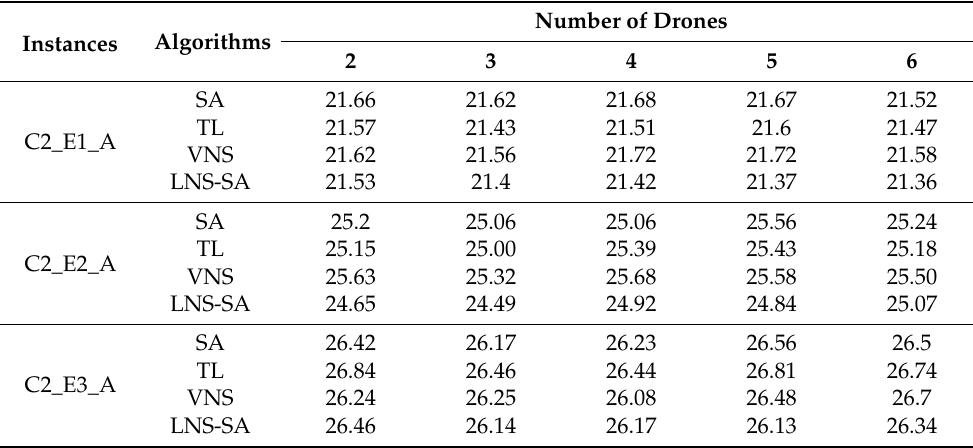
Table 8. Experimental results with different drone